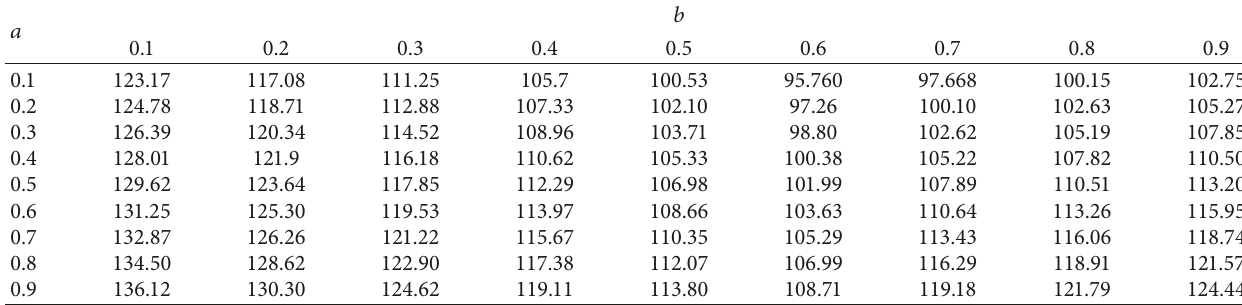
Table 4: Standard deviation under different combinations of a and b .